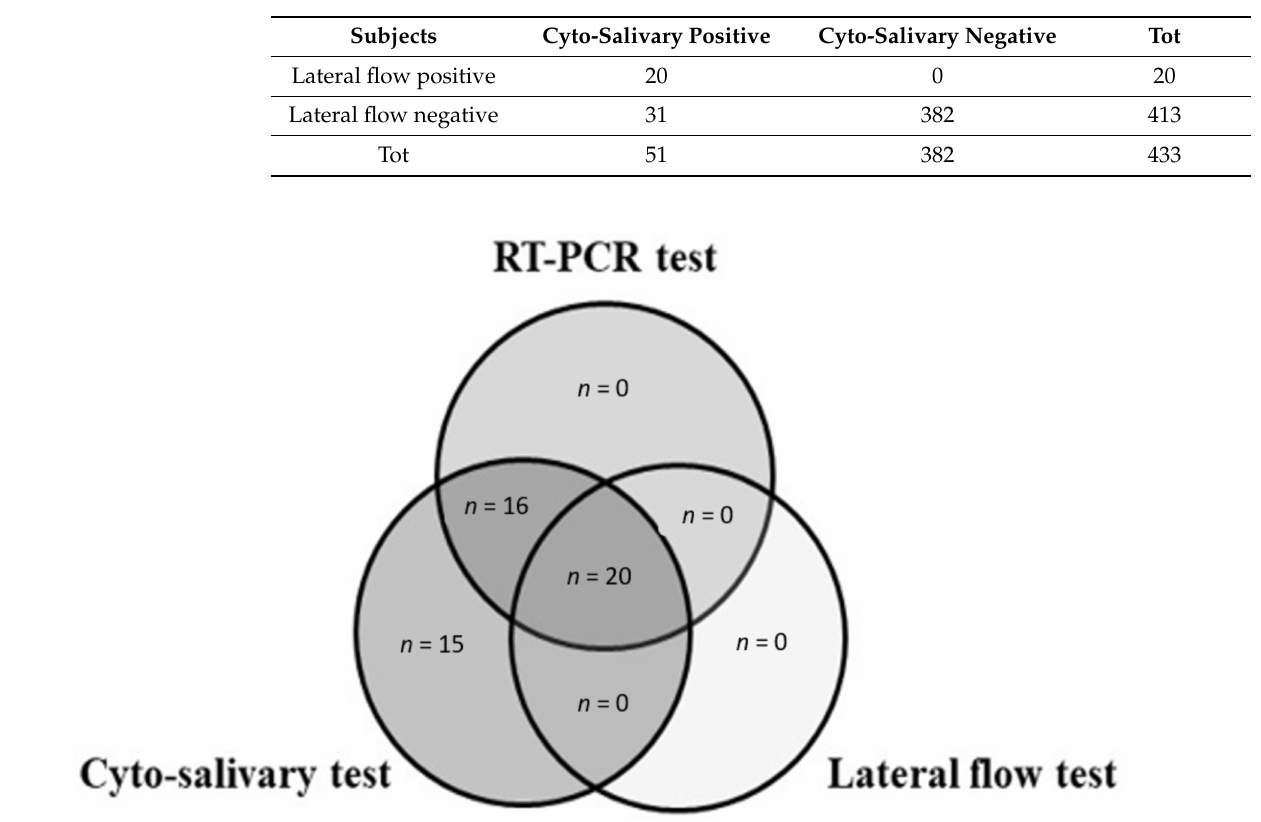
Figure 1. Venn plots show the overlapping of positive cases of the three tests performed (cyto-salivary, lateral flow and RT-PCR), n = number of positive